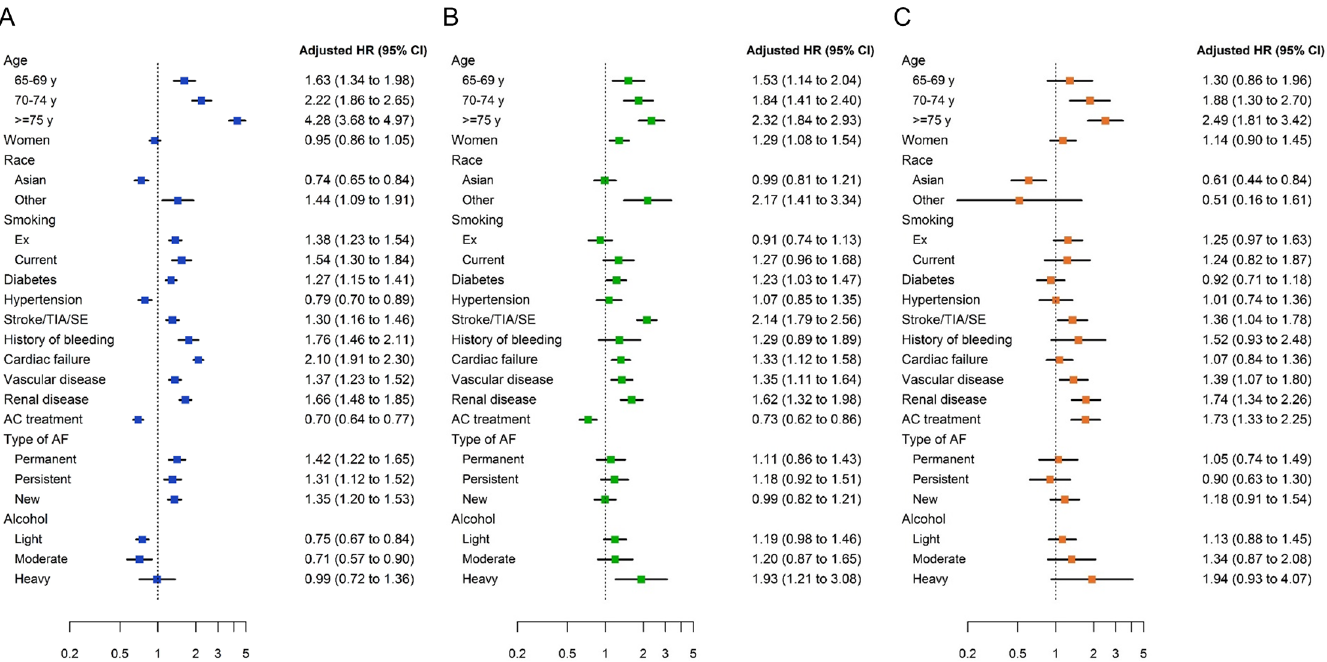
Fig 1. Adjusted hazard ratios for 2-year outcomes according to baseline characteristics and anticoagulant treatment: (A) all-cause mortality; (B) stroke/systemic embolism; (C) major bleeding. ‘Anticoagulant treatment’ includes both vitamin K antagonists and non-vitamin K antagonist oral anticoagulants. For race, ‘Asian’ includes Asian (not Chinese) and Chinese, and ‘other’ includes Afro-Caribbean, mixed/other, and unwilling to declare/not recorded. Reference groups, from top: < 65 years, men, Caucasian/Hispanic/Latino, never smoker, no history of disease (for diabetes, hypertension, stroke/TIA/SE, history of bleeding, cardiac failure, vascular disease, and renal disease), no AC treatment, paroxysmal AF, alcohol abstinence. Hazard ratios were adjusted for all variables in the model. AC, anticoagulant; AF, atrial fibrillation; CI, confidence interval; HR, hazard ratio; SE, systemic embolism; TIA, transient ischaemic attack.